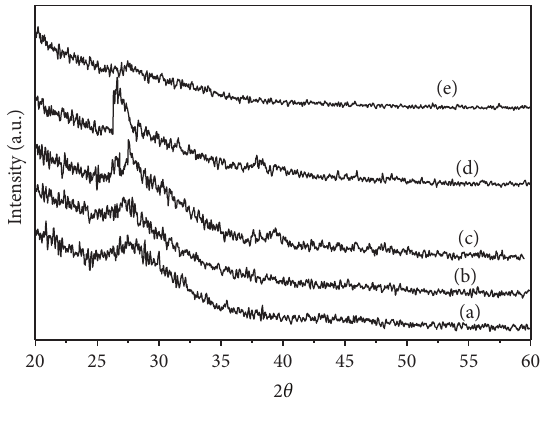
F 4: e X-ray diffraction patterns of the Li ion-irradiated glass thin �lms for BBiSB series: (a) unirradiated; (b) 14+ 12 ions/cm 1 × 10